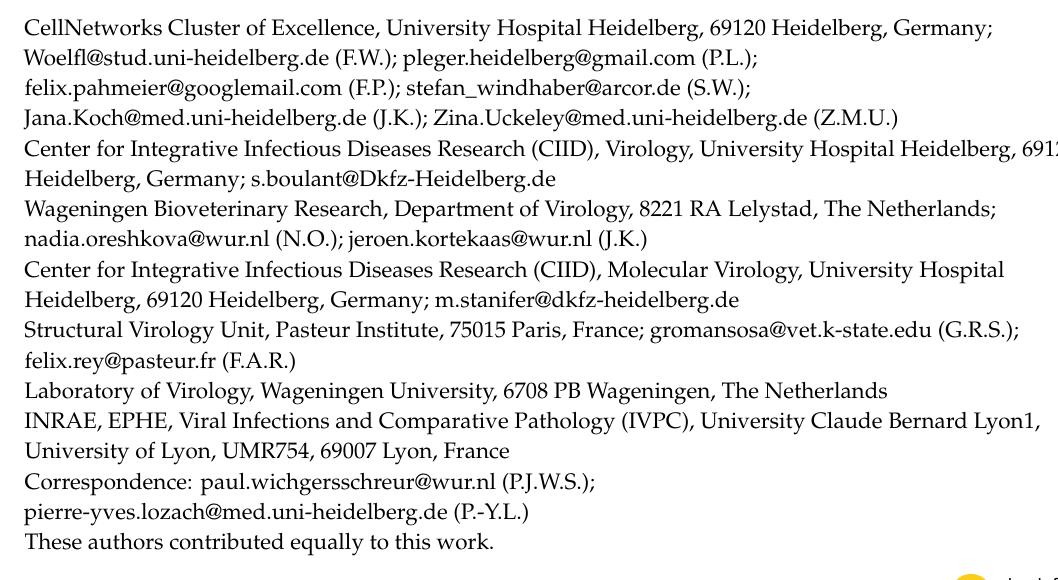
Table 1. List of polyclonal antibodies generated in this study.